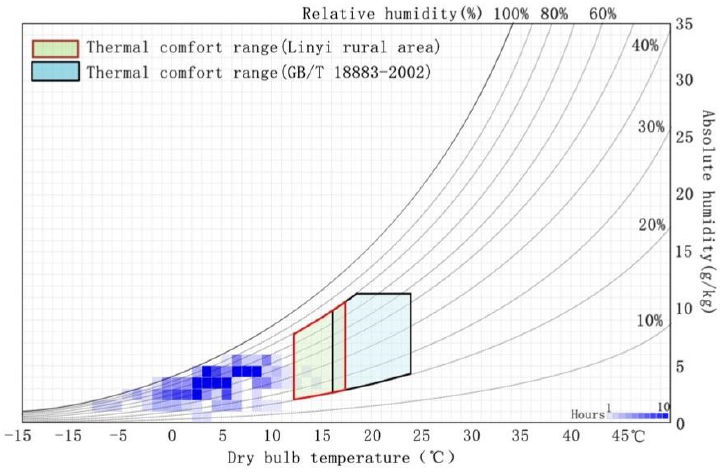
Figure 26. Comparison of thermal comfort zone in winter.